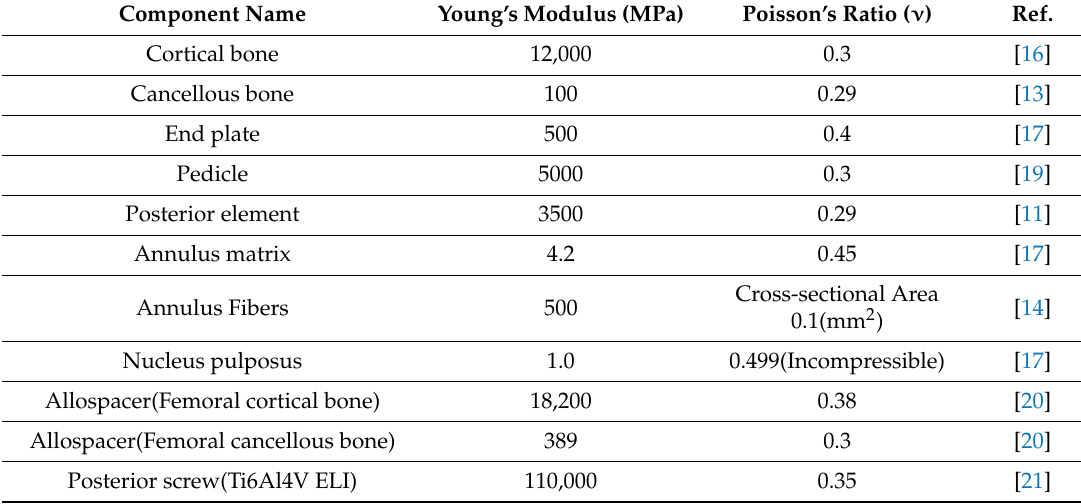
Table 2. Material